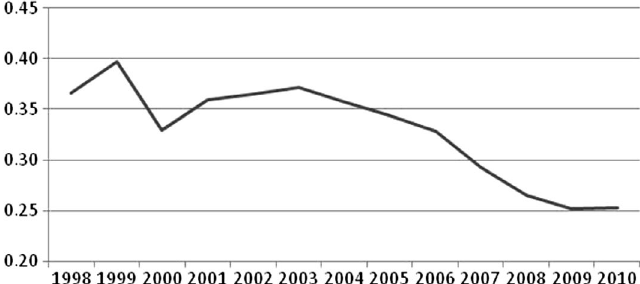
Fig. 3. Sigma convergence of net earnings ratio expressed in purchasing power parity, in the EU-8+2 according to the average net earnings in the EU-15, 1998–2010 Source: Authors’ calculation based on Eurostat database 2012.